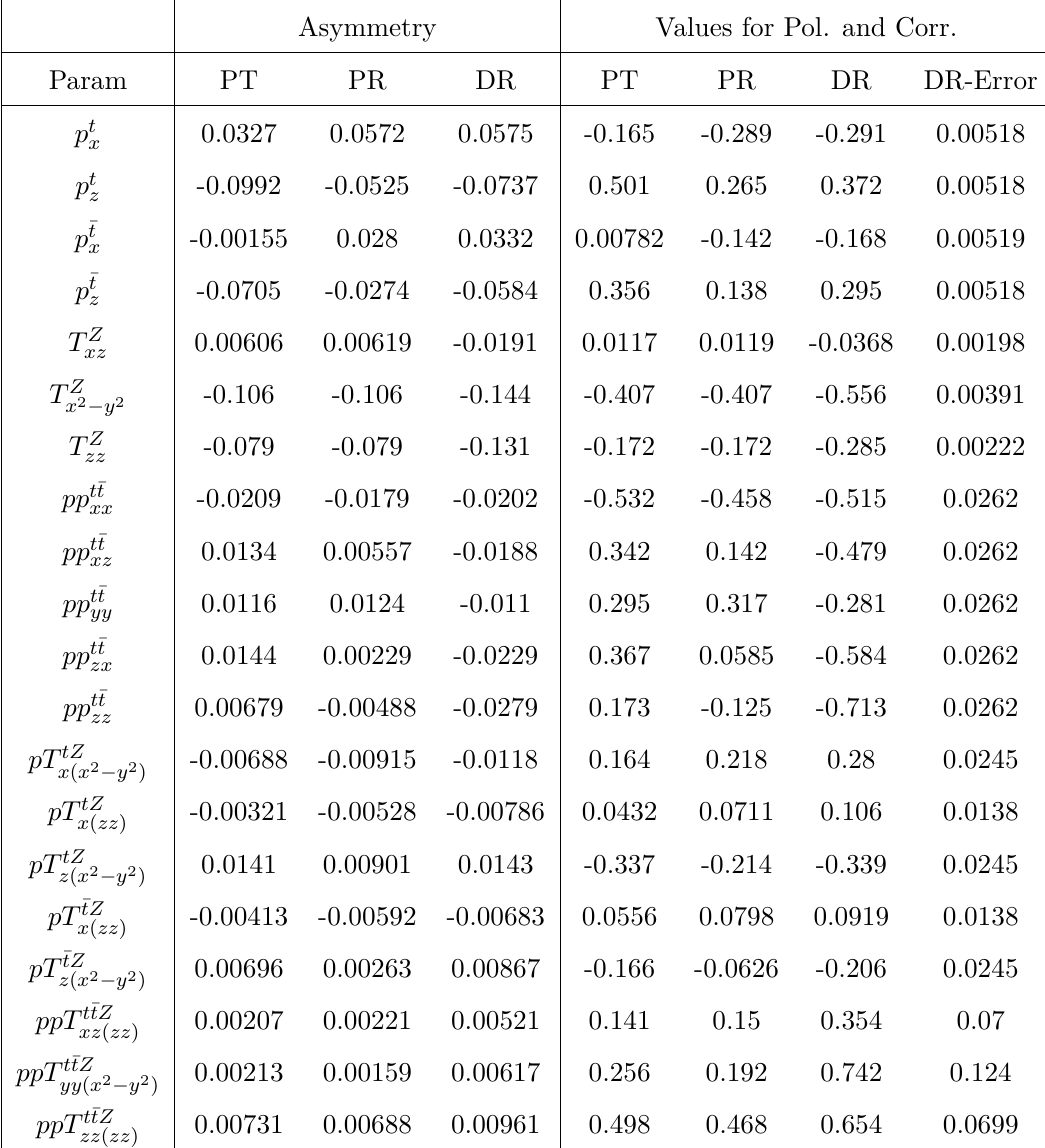
Table 4 . Standard Model values of various polarizations and spin correlations along with their asymmetries above in parton level as well as in detector level in the t ¯ tZ production in the 4 l √ channel at the s = 13 TeV LHC. The values are listed with asymmetries more than 5 σ MC error of 10 million events ( δ A = 0 . 001 ) in Delphes level. PT, PR and DR stands for Parton-Truth , Parton-Reco , and Delphes-Reco ,